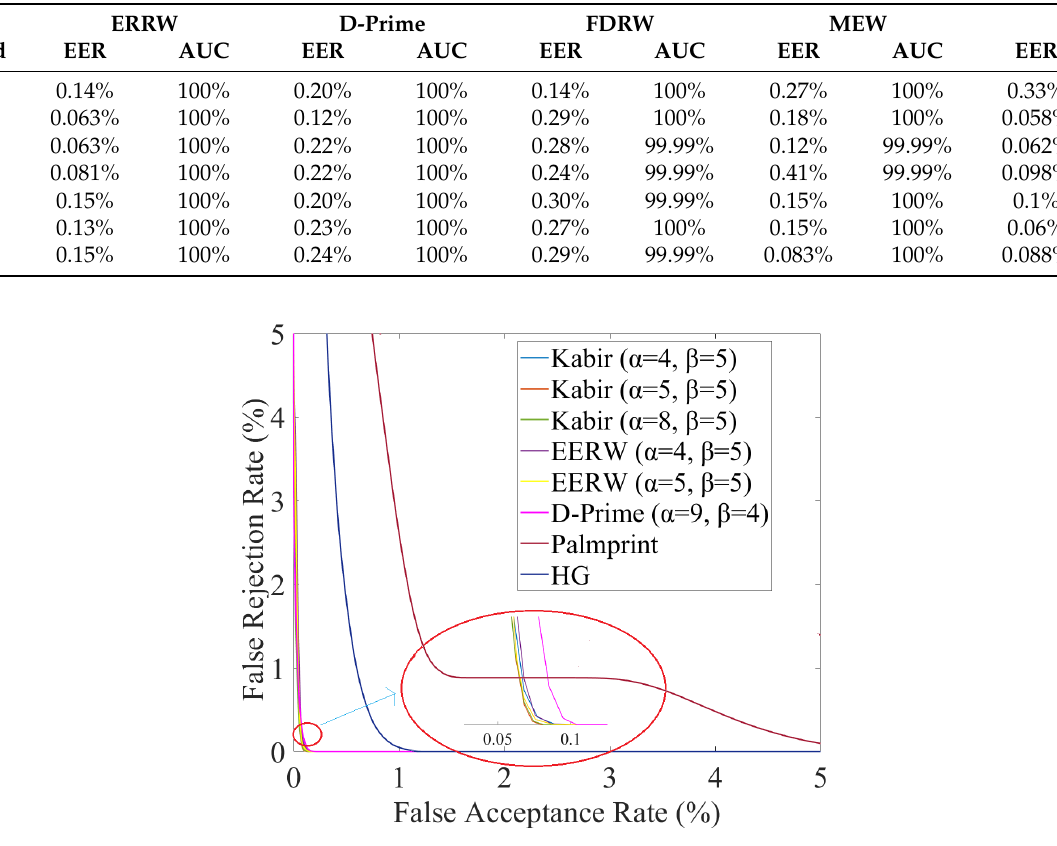
Figure 6. DET curves obtained with the best fusion methods. Best unimodal palmprint and hand geometry curves are also reported for